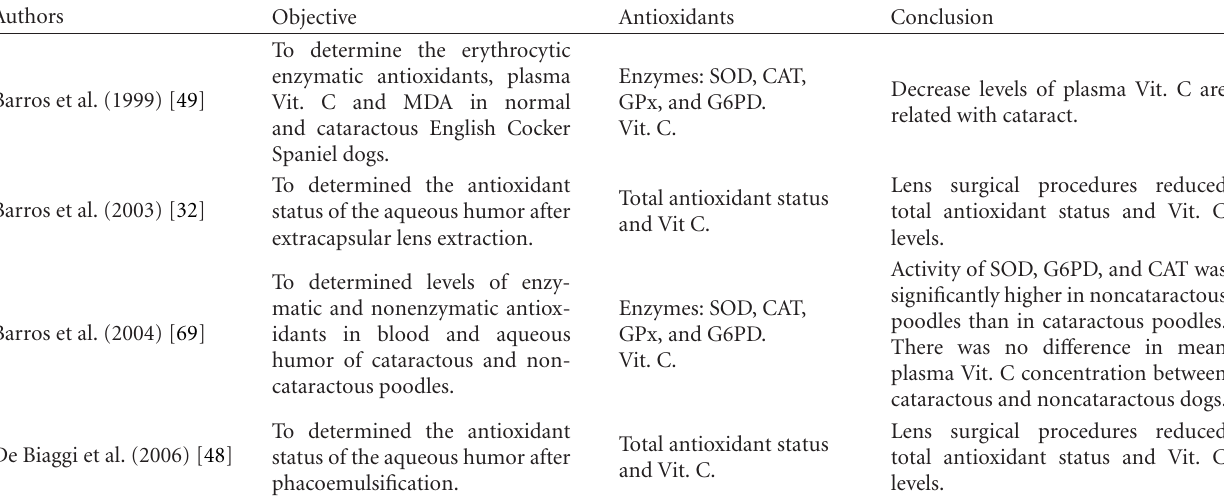
Table 2: Animal research comparing antioxidants and/or plasma levels of antioxidants molecules with degenerative changes in dogs.